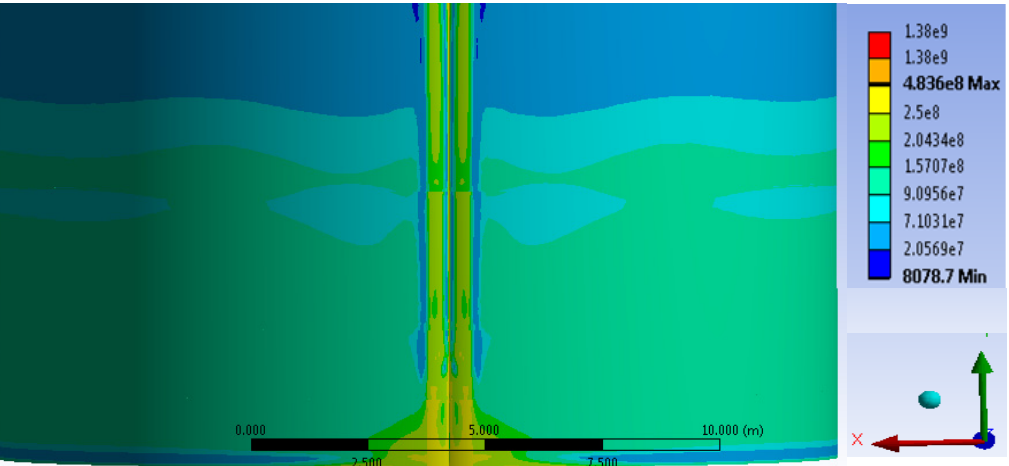
Figure 15. Distribution of equivalent stresses in the field joint zone with the joint imperfection at a = 50 cm; f = 1 cm.